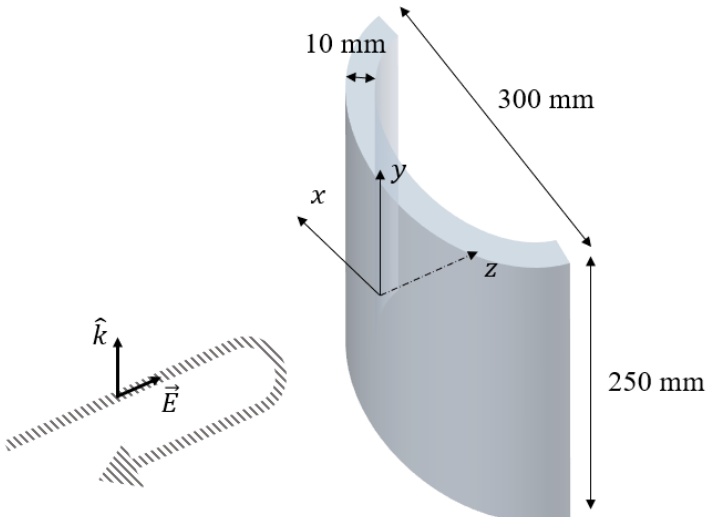
Figure 7. A singly curved dielectric for RCS Estimation.